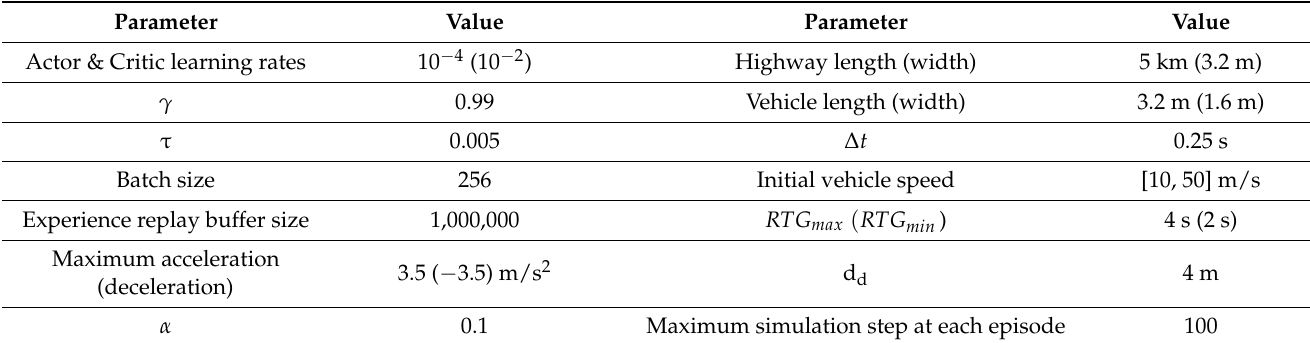
Table 1. Simulation settings and DDPG